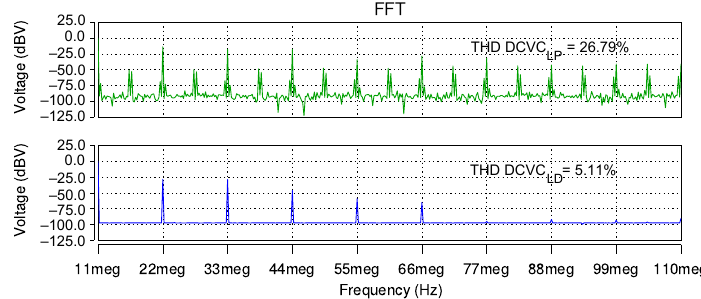
Figure 8. Post-layout THD comparison for DCVC LP and DCVC LD . The energy-delay product, as a figure-of-merit (FoM), was estimated in both circuits with an input signal of 1.1 GHz. Table 2 provides the FoMs for DCVC LP , DCVC LD , and DCVC LDm —the low-power consumption version of DCVD , the low distortion version of DCVC , and the fabricated DCVC , respectively. As shown, DCVC LD showed increased power consumption with improved the signal integrity. The power consumption and delays of DCVC LDm were average values, in terms of the measurements of the non-encapsulated die of the transimpedance amplifier. For power consumption estimations, the worst case corner was used in the simulations.In this case, Table 2 illustrates that the EDP for DCVC LP was reduced by 44% compared to DCVC LD . However, as shown in Table 2, the measured power consumption of the implemented version of DCVC LD , referred to as DCVC LDm , increased by